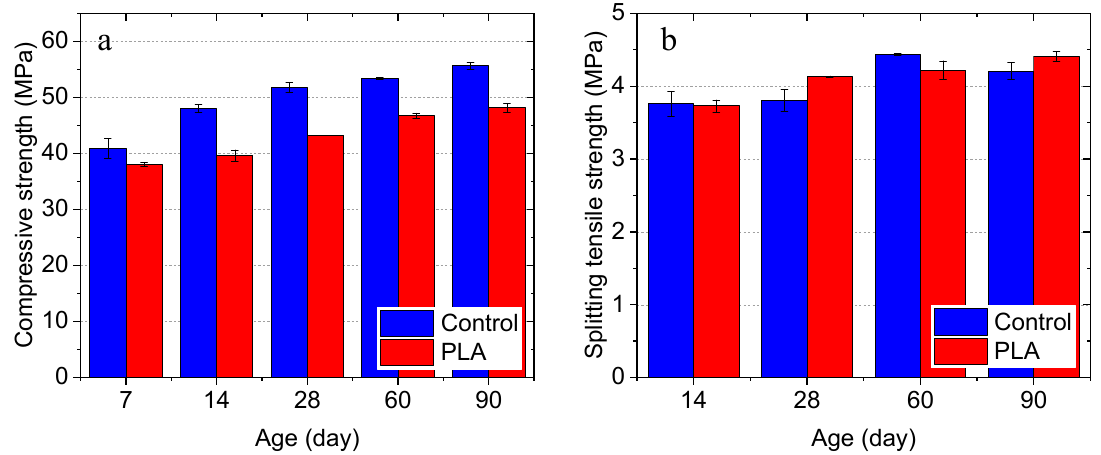
Figure 12. Strength development of concrete cylinders in ( a ) Compression, and ( b ) tension.